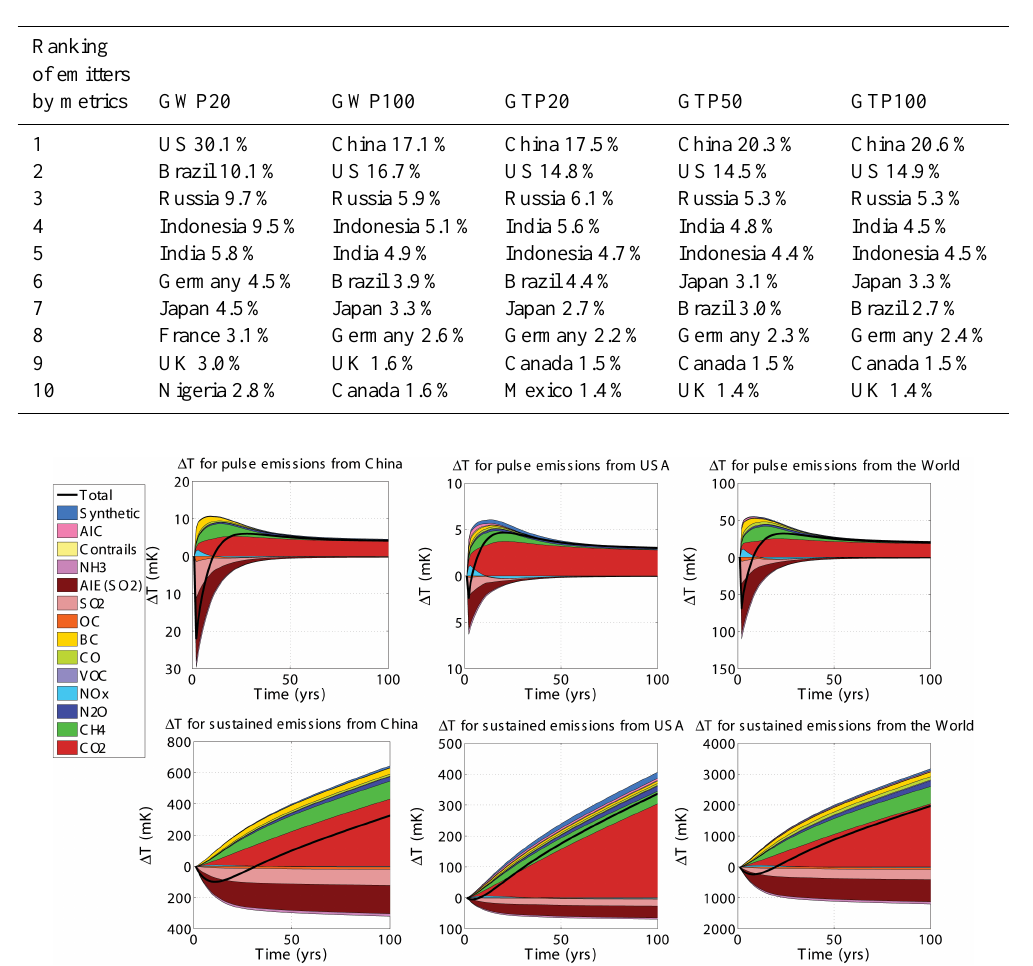
Table 4. The top ten emitting countries according to different emission metrics. The percentage given is the share of the global sum.